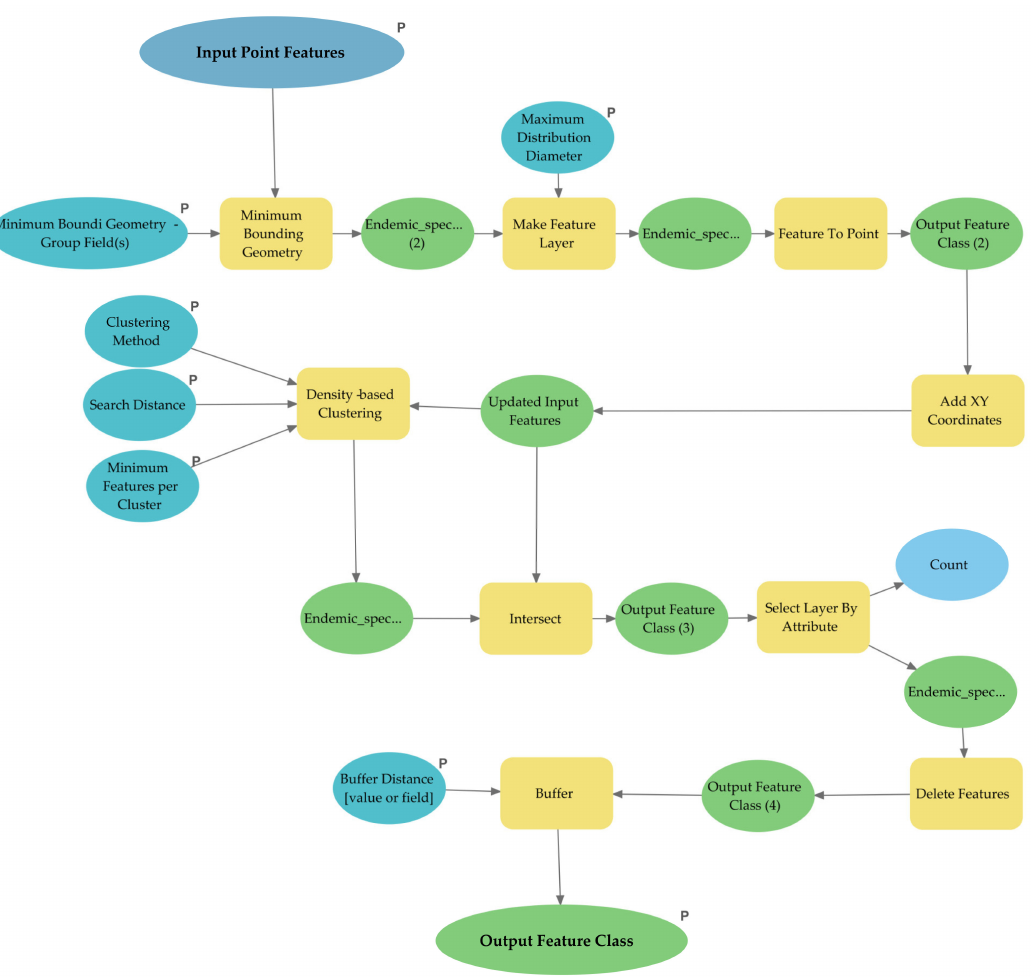
Figure 2. Scheme of the CLUENDA toolbox, developed in ArcGIS Pro